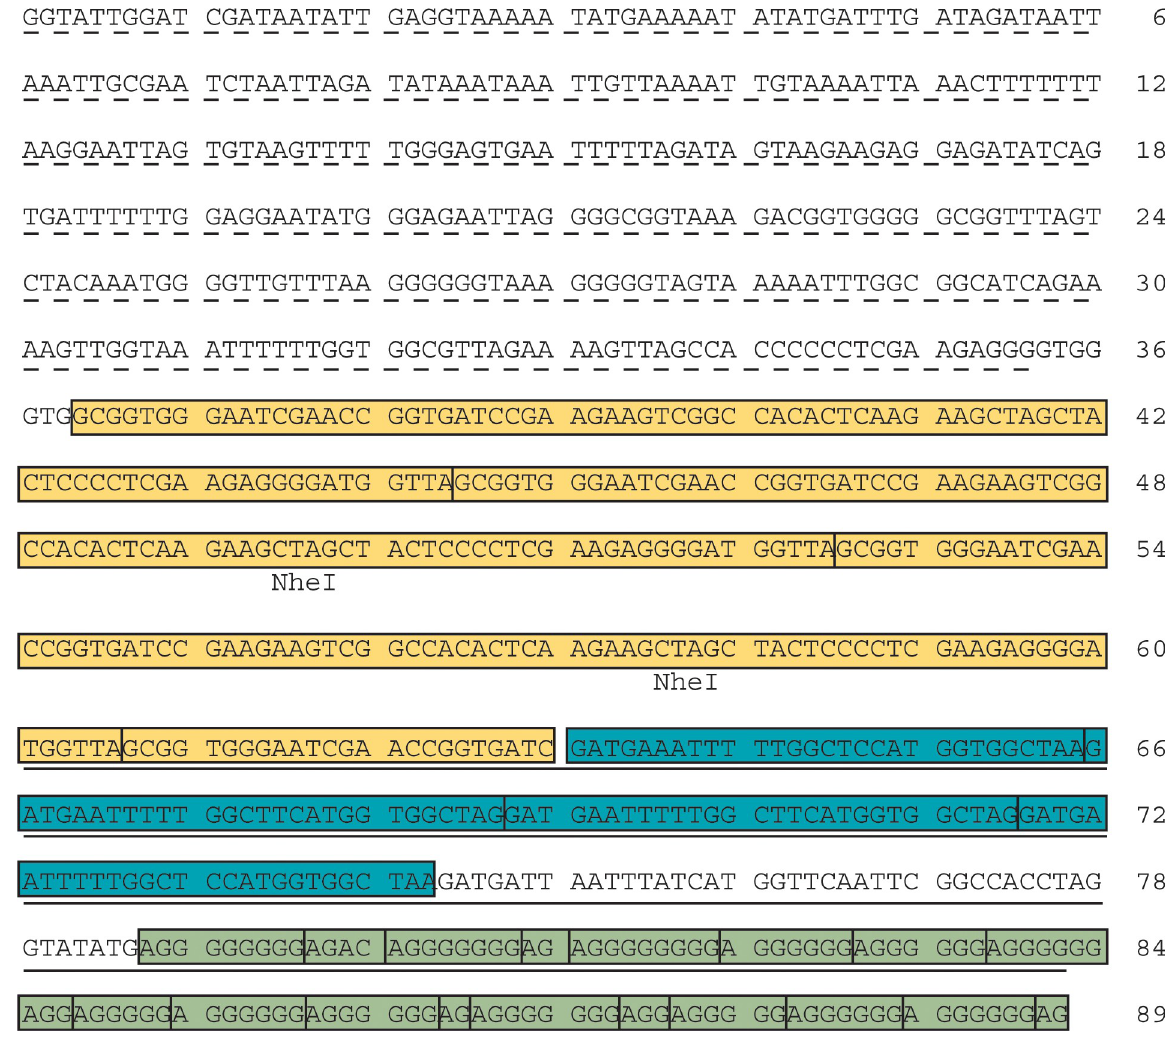
Fig 2. Nucleotide sequence of the terminal region of the D . discoideum rDNA palindrome. The nucleotide sequence of several PCR products corresponding to the terminal region of the rDNA palindrome was determined and the aligned sequence obtained is shown. The sequence underlined with a broken line (nucleotides 1 to 356) is coincident with the terminal fragment of the rDNA palindrome described in the Dictybase (http://dictybase.org/). The sequence underlined with a continuous line (nucleotides 602 to 898) corresponds to the sequences described by Emery et al , merged and reorganized. The nucleotide sequence corresponding to the more upstream repeats (repeats A in Fig 3) is shadowed in yellow, that of the middle repeats (repeats B in Fig 3) in blue, and the terminal repeats (C in Fig 3) in green. Individual repeats of each type are separated by vertical lines. The location of the NheI restriction sites used for Southern analyses is indicated underneath the respective